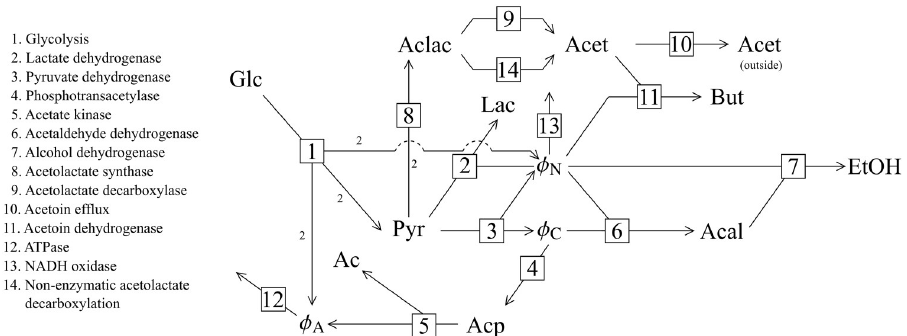
Fig 2. The pyruvate branch pathway. Reactions are numbered according to the key. For the sake of brevity we refer to the reactions by their number instead of their name throughout this paper. The stoichiometry of each reaction is 1 to 1, except for reaction 1 where Glc + 2ADP + 2NAD + ! 2Pyr + 2ATP + 2NADH and reaction 8 where 2Pyr Ð Aclac. Intermediates are abbreviated as follows: Ac: acetate; Acal: acetaldehyde; Acet: acetoin; Aclac: acetolactate; Acp: acetyl phosphate; Glc: glucose; Lac: lactate; But: 2,3-butanediol; Pyr: pyruvate; EtOH: ethanol; ϕ A : ATP/ADP; ϕ C : acetyl-CoA/ CoA;